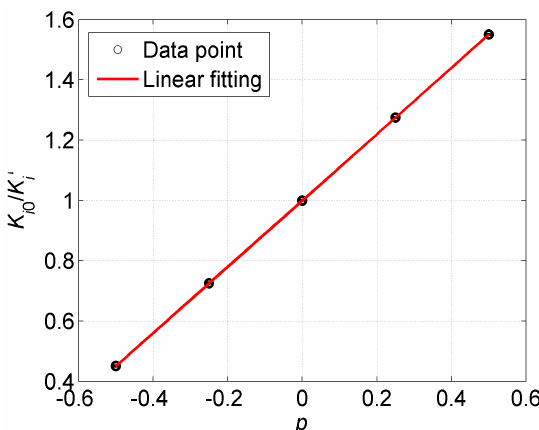
Figure 5. Linear fitting the ratio of K i 0 / K (cid:48) varying with the coefficient p according to Equation (8). The standard deviation of each point is at the order of 10 − 4 .